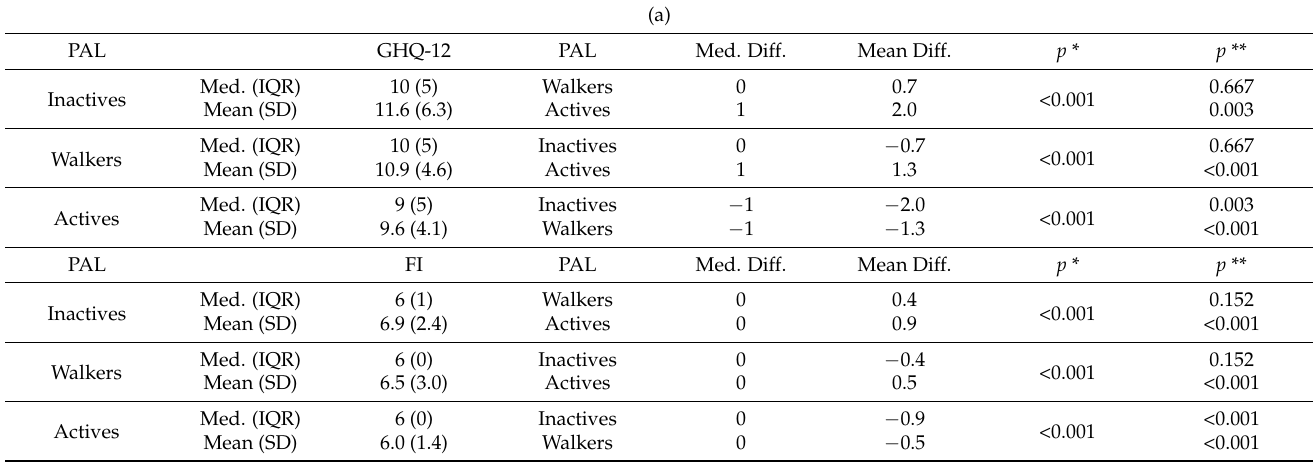
Table 4. Associations between the (a) male and (b) female informal caregivers’ physical activity level and mental health and its subscales through the Goldberg General Health questionnaire according to the Spanish National Health Survey